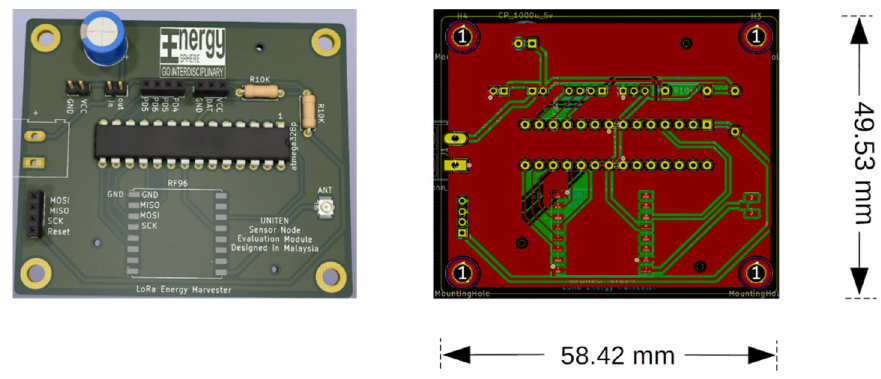
Figure A1. The PCB design of the WSTx.